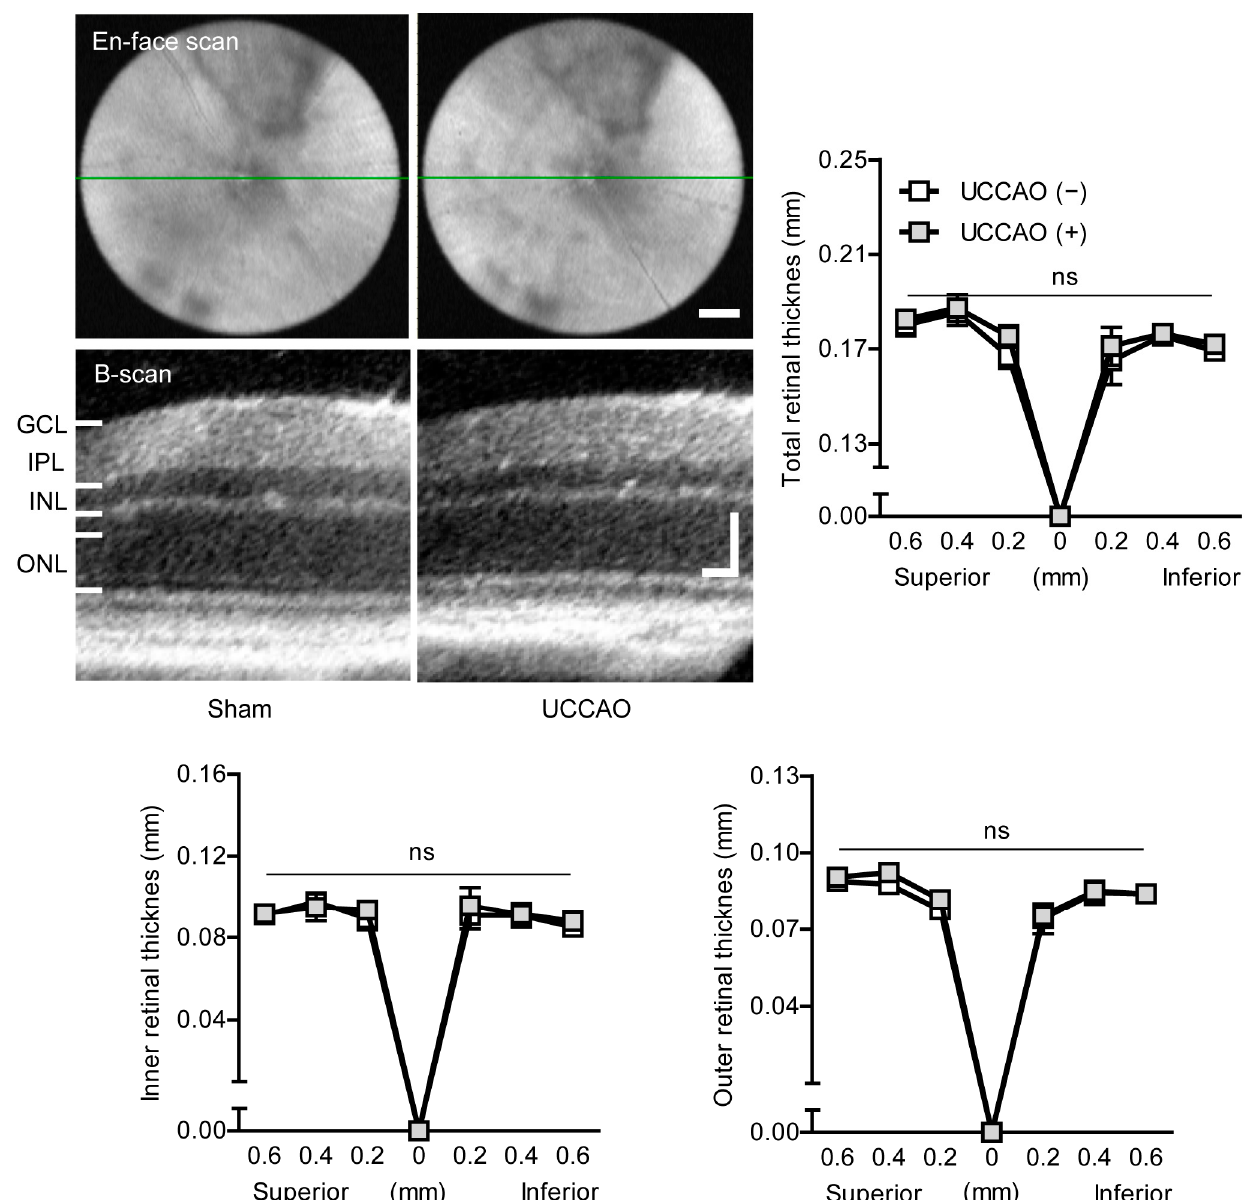
Figure A2. No change in retinal thickness after UCCAO. Representative optical coherence tomography (OCT) images (b-scan) in the sham- and UCCAO-operated retinas and quantitative analyses ( n = 4–5 per group) show that there was no change in retinal thickness a week after UCCAO. The values in the horizontal axis of the graph represent 0.2, 0.4, and 0.6 mm distance from the optic nerve head (0) which was detected by the green line (en-face scan). Representative OCT images were taken at 0.4 mm from the optic nerve head. The data were analyzed using two-way ANOVA followed by a Bonferroni post hoc test and presented as a spider diagram (mean ± standard deviation). p > 0.05. GCL, IPL, INL, and ONL represent the ganglion cell layer, inner plexiform layer, inner nuclear layer, and outer nuclear layer, respectively. Scale bars are 200 (upper) and 50 (lower; vertical and horizontal bars) μ m, respectively. UCCAO; unilateral common carotid artery occlusion.